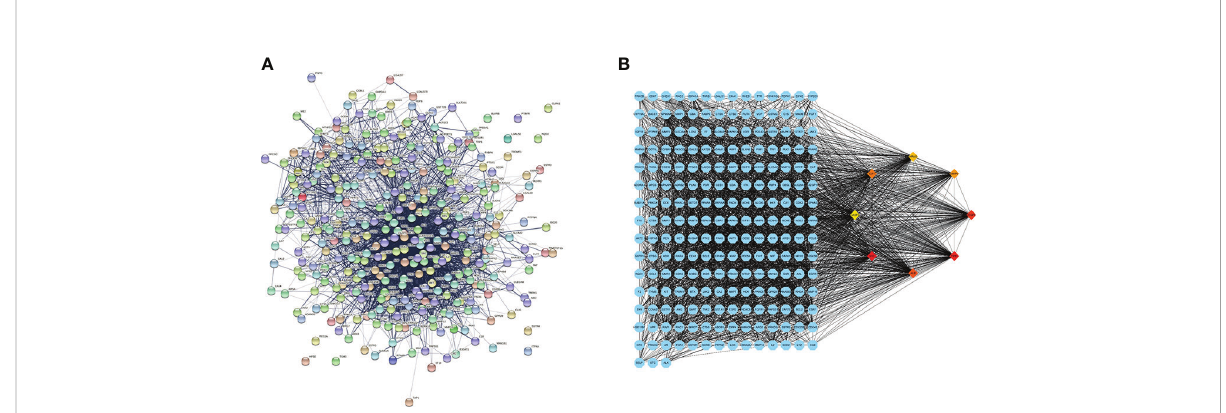
FIGURE 2 Protein – protein interaction (PPI) network diagram and the identi fi ed hub genes. (A) PPI network. (B) PPI map showing key genes; changes are presented based on the size and color of degree